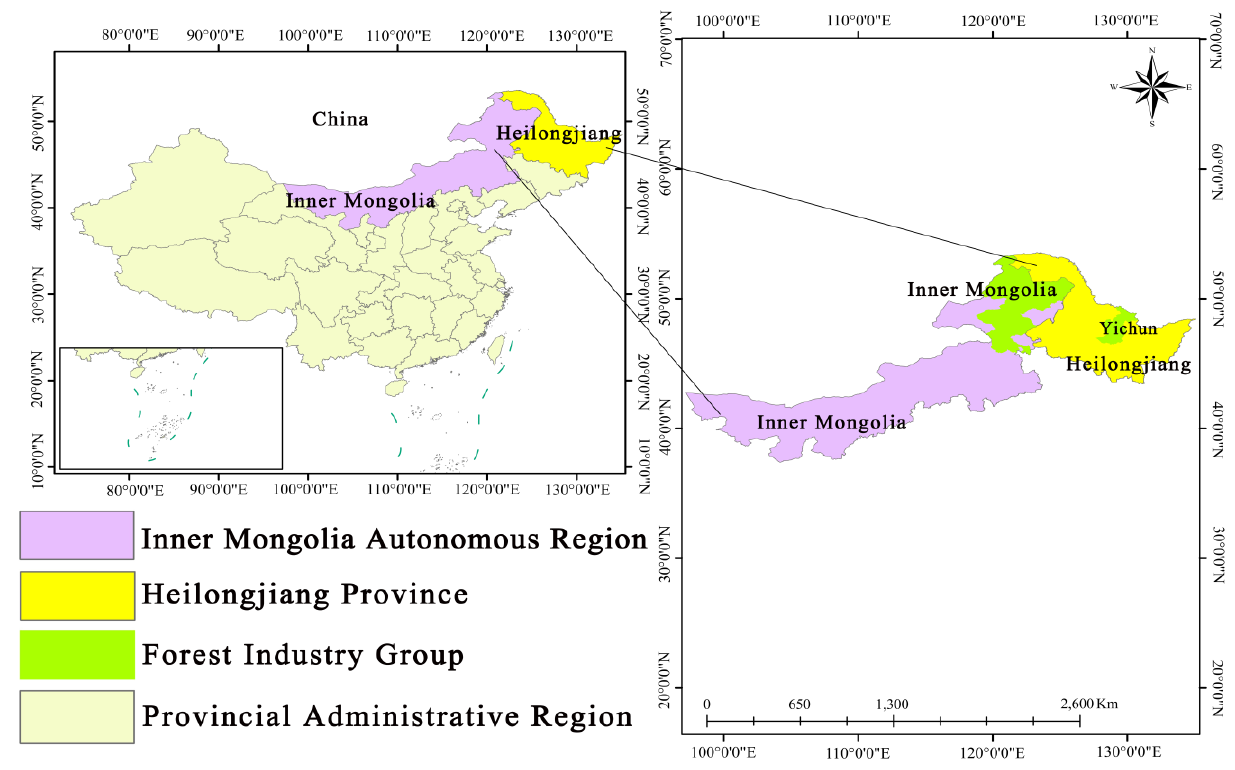
Figure 1. Location of the study area.